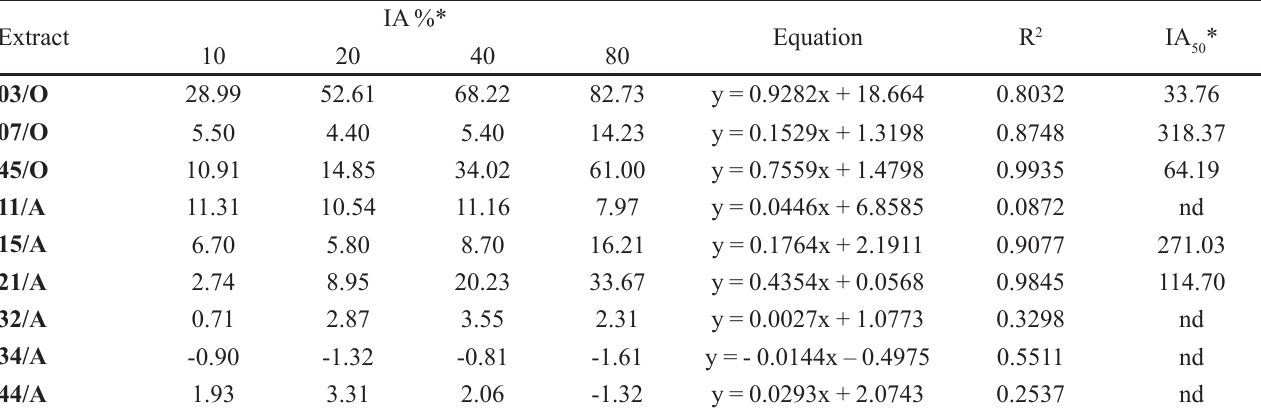
TABLE III - Tyrosinase inhibitory activity of plant extracts. Extract